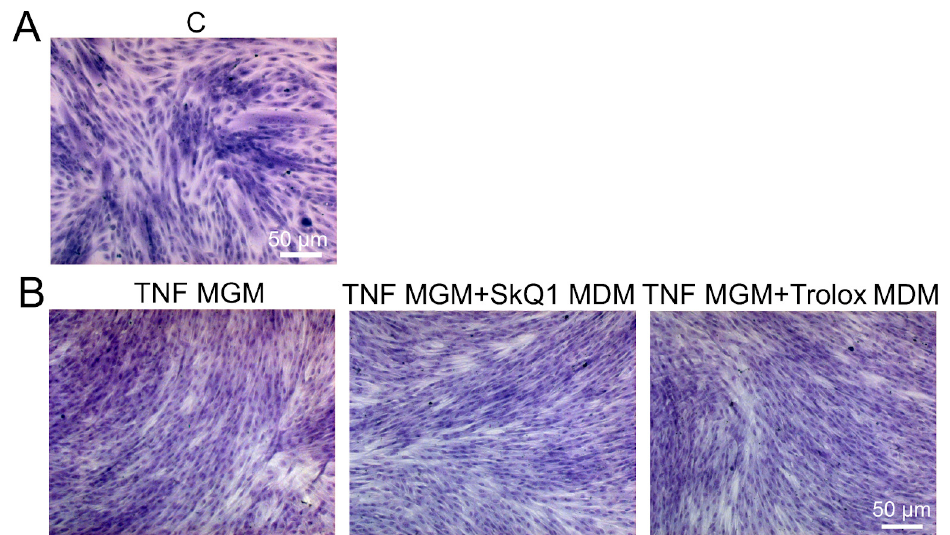
Figure A3. Antioxidants added only to the differentiation medium (MDM) do not restore myogenesis impaired by TNF added to the growth medium (MGM). Myoblast fusion was assessed on the 3rd day after differentiation induction using May–Grunwald staining. Representative images are shown, scale bar: 50 μ m. Control cells are shown in ( A ). ( B ) Cells were treated with TNF (50 ng/mL) 24 h before the induction of differentiation. Antioxidants SkQ1 (40 nM) and Trolox (100 μ M) were added into the differentiation medium only.